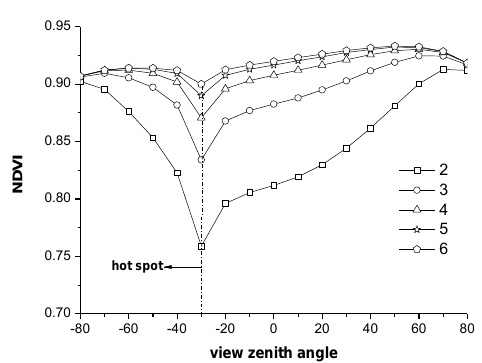
Figure 3. NDVI distributions in the view zenith angles with different LAI